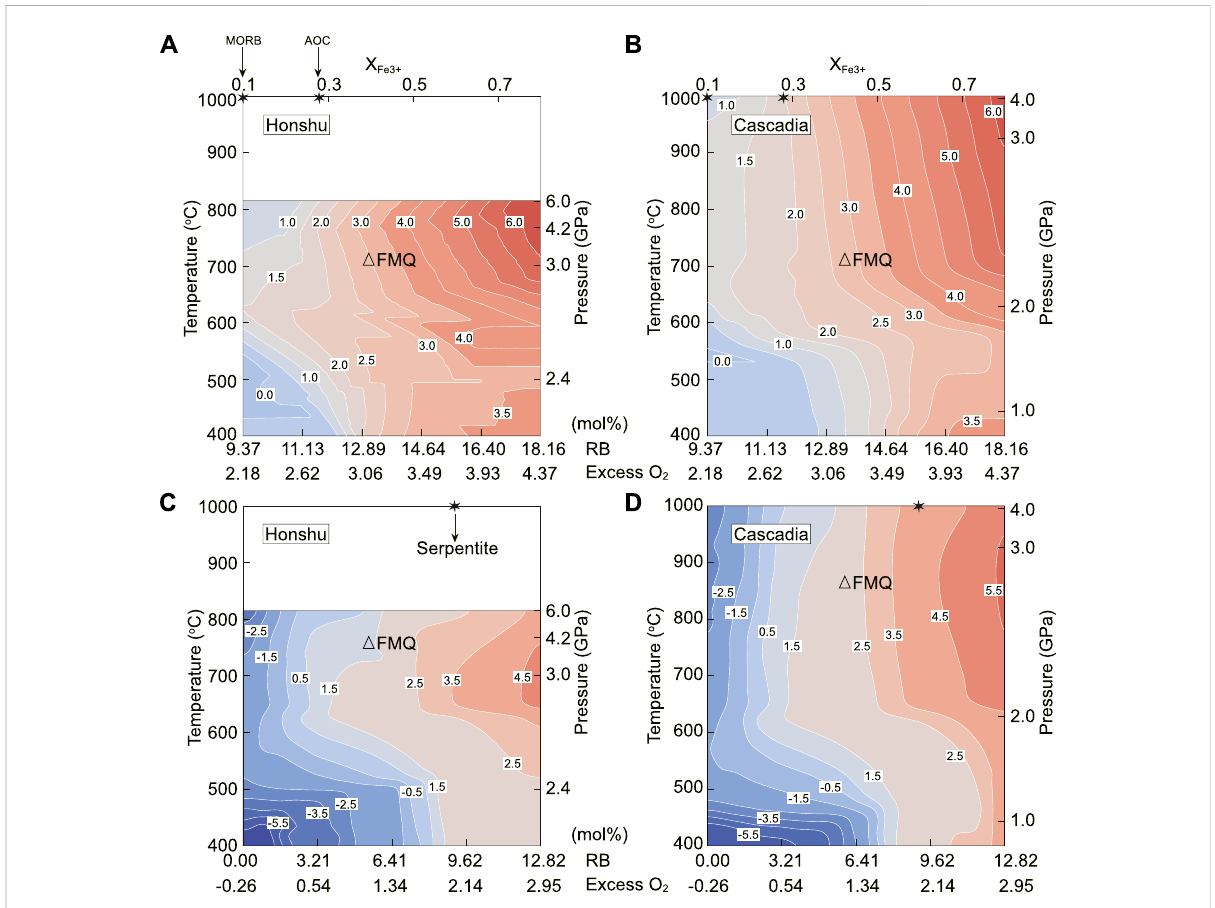
FIGURE 4 T/P -RB pseudosections showing the f O fl uids along the Honshu and Cascadia 2 variations of the AOC (A, B) - and serpentinite (C, D) -derived geotherms. RB in AOC is a function of n (Fe 3+ ), mol, varying from 9.37 (X Fe3+ =0.1, MORB) to 18.16 (X Fe3+ =0.8) (Rutter, 2015) with fi xed C and S contents (Staudigel et al., 1989; Evans, 2012). RB in serpentinite was adjusted by fi xed contents of iron, carbon, and sulfur but with variable valence state (Evans and Powell, 2015), varying from 0.00 (assuming C is C 0 , Fe is Fe 2+ and S is S 2- ) to 12.82 (X Fe3+ =1 with fi xed carbon and sulfur speciation from Alt et al. (2012) and Evans (2012)). The stars represent the reference RBs of MORB (9.37) and AOC (11.63) and the averaged serpentinite